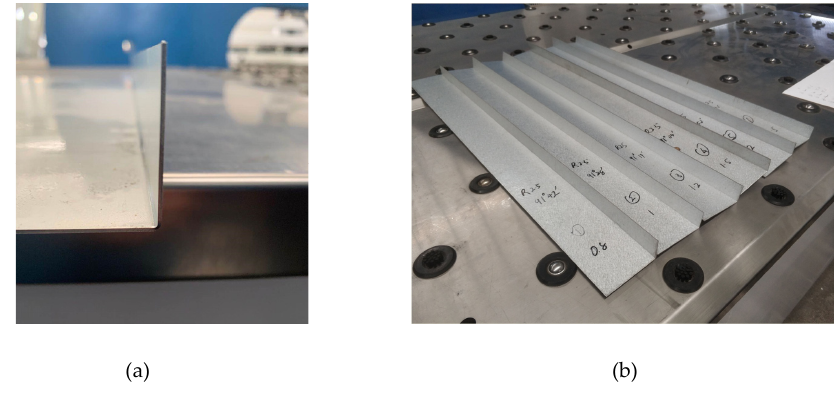
Figure 13. Bent plate samples: ( a ) Sample 1. ( b ) Sample 2.